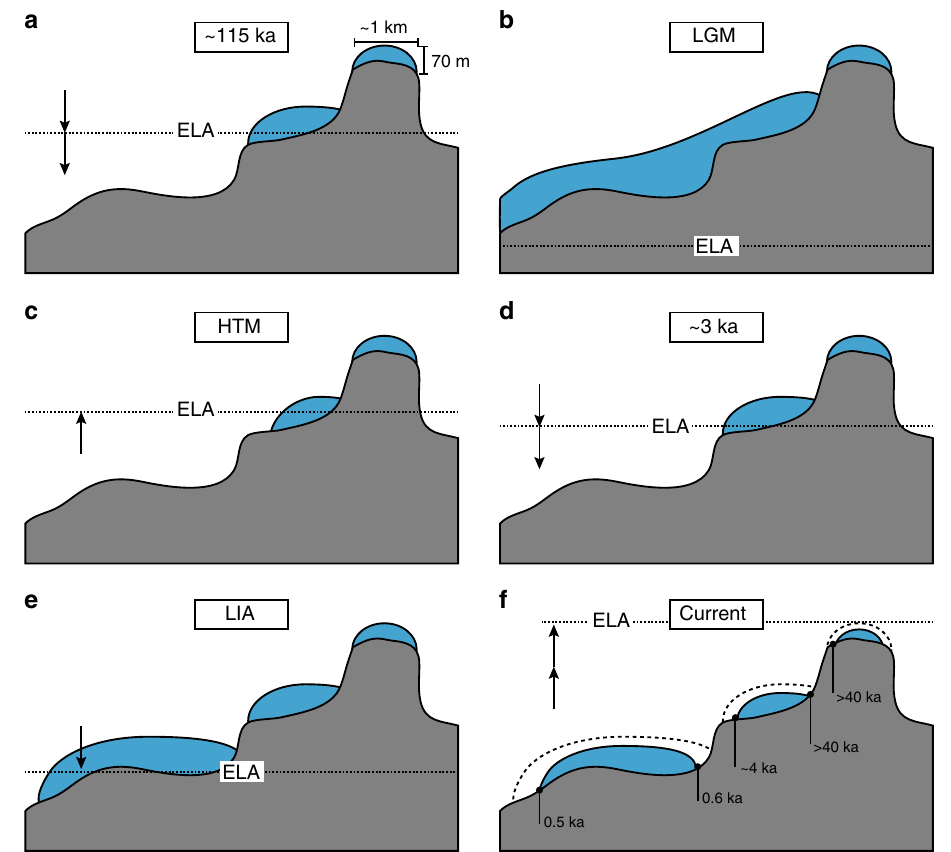
Fig. 4 Ice cap response to rapid equilibrium line altitude (ELA) rise exposes landscapes of varying ages. Conceptual time series of ELA change illustrating the threshold behavior of pedestal ice caps that reach and maintain their maximum dimensions even when the ELA is relatively high ( a ). During the LGM, much of the landscape is covered with ice but additional growth of pedestal ice caps is limited by topography ( b ). As ELA rises during the deglaciation and early Holocene, many low elevation ice caps disappear, intermediate elevation ice caps recede, whereas pedestal ice caps maintain their size ( c ). Renewed descent of ELA during the Holocene permits lower elevation ice caps to reform ( d , e ). The anomalous rise of the ELA over the past century has been so rapid that ice caps are no longer in equilibrium with climate; consequently, the thickest ice caps, often at lower elevation than pedestal ice caps, take longest to disappear, revealing a range of Holocene plant 14 C ages ( f (Supplementary Table 2). A linear least squares fi t to the upper, lower, and two intermediate values was used to estimate the blanks during the time-dependent period. In all, 30,900 14 C atoms is a conservative error estimate for all process blanks. M14-B090R was analyzed on a separate extraction system with a corre- sponding process blank of 160,700 ±12,100 14 C atoms. The detection limit is considered to be the uncertainty associated with the process blank measurement 19 . Accounting for the 10g of quartz dissolved for each sample, all reported con- centrations are above established detection limits 21 . In situ 14 C production simulation . For each realization of ice thickness history for each sample, we determine the production rate at the rock surface ( P o ; at g − 1 yr − 1 ) from site elevation, latitude (LSD n scaling framework) 25,39 – 41 , while accounting for attenuation of spallogenic 14,42 and muogenic 15 – 17,43 production due to ice thick- ness at each timestep. The in situ 14 C concentrations are iteratively calculated at annual time steps using the following equation 44 – 49 :